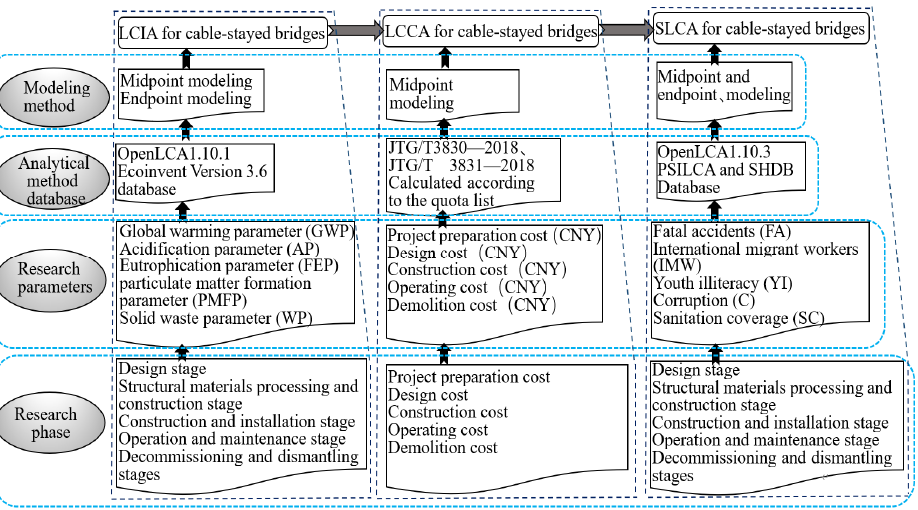
Figure 2. Schematic diagram of the LCIA, LCCA, and SILA analysis process.